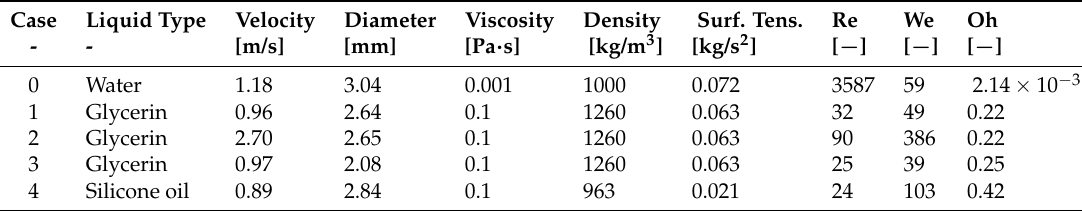
Table 2. Operating parameters for validation, from